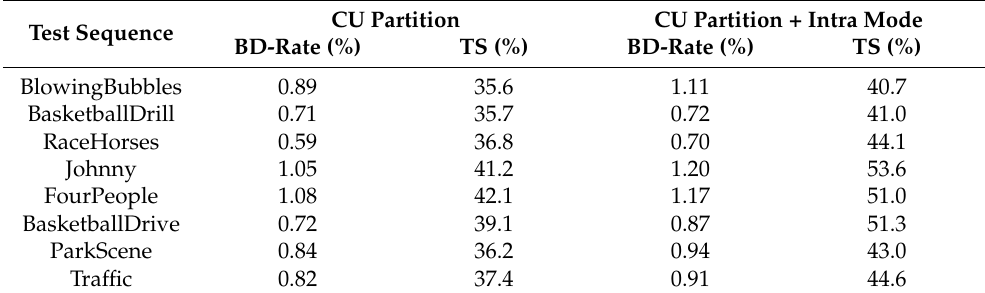
Table 5. The encoding performance of the proposed individual method with HM